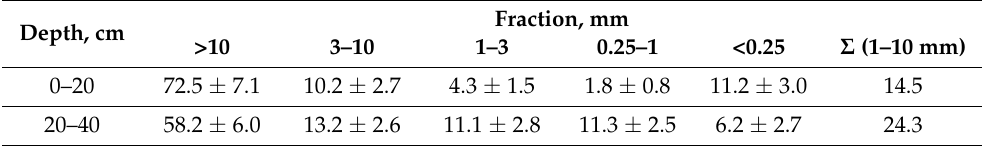
Table 1. Soil aggregate composition of the solonetz before processing (dry sieving),